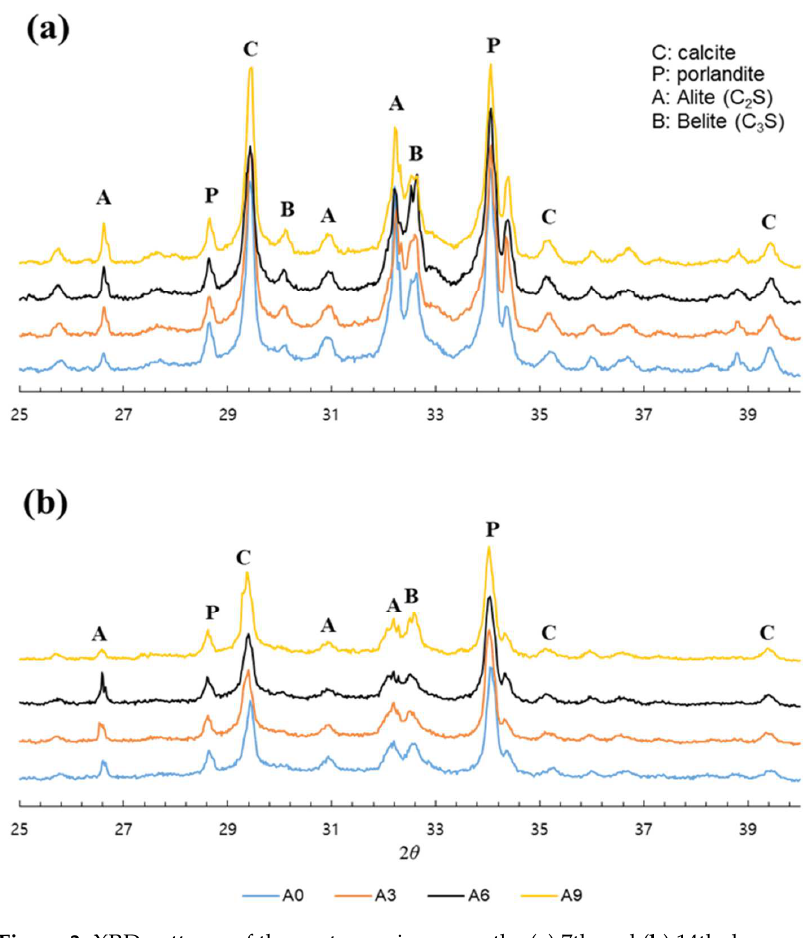
Figure 3. XRD patterns of the paste specimens on the ( a ) 7th and ( b ) 14th days.